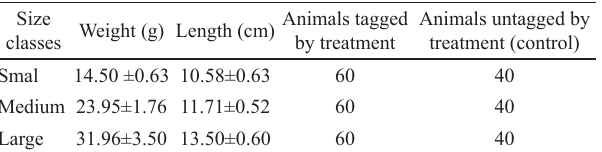
Tab. 1. Mean and standard deviation of the weight and len- gth of the Lophiosilurus alexandri used in the different size